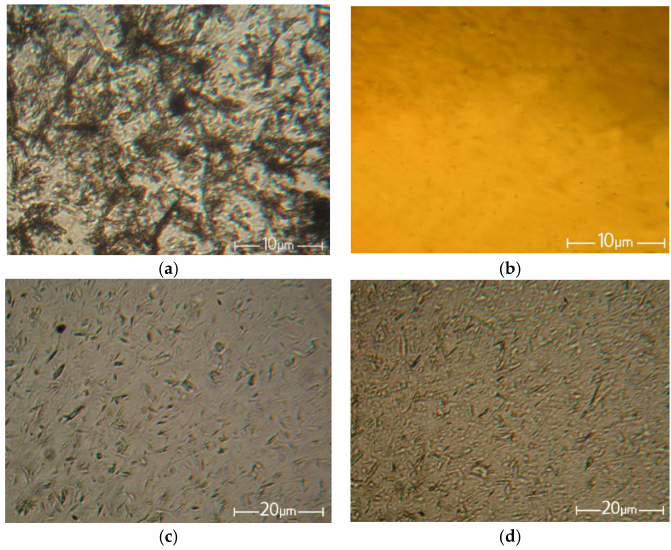
Figure 3. Morphology of the betulin particles ( a ), 18% solution of cellulose in NMMO ( b ), and cellulose solution with betulin with a ratio of the cellulose to betulin of 95:5 ( c ) and 90:10 ( d ).